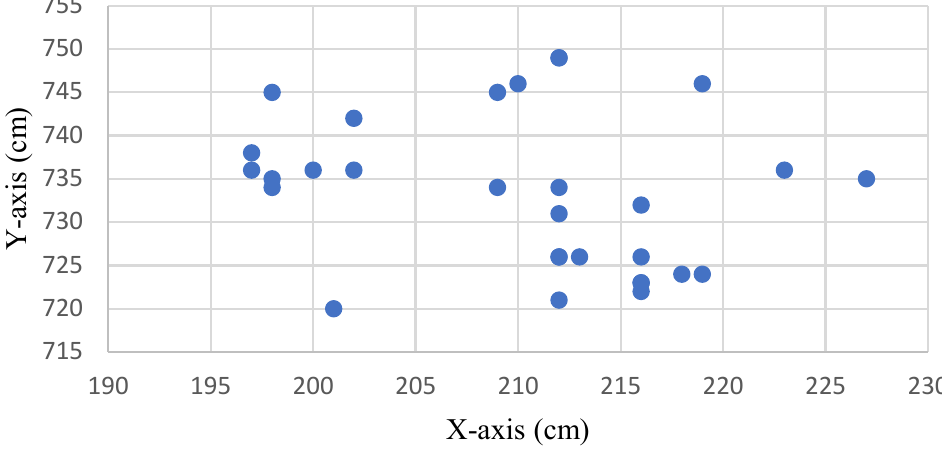
Figure 7. Distribution of the original measurement positioning points without drift correction.